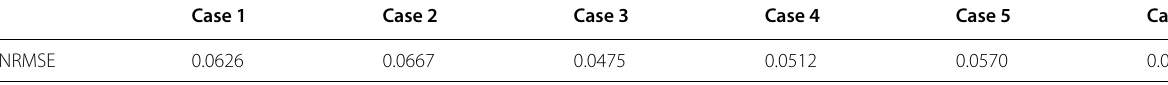
Table 1 NRMSE values of estimated displacements under six different